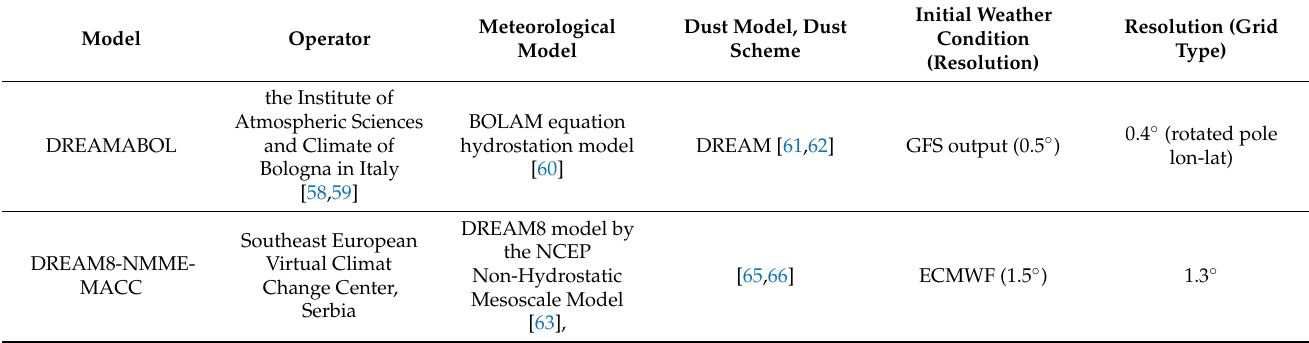
Table 3. Specifications of selected numerical prediction